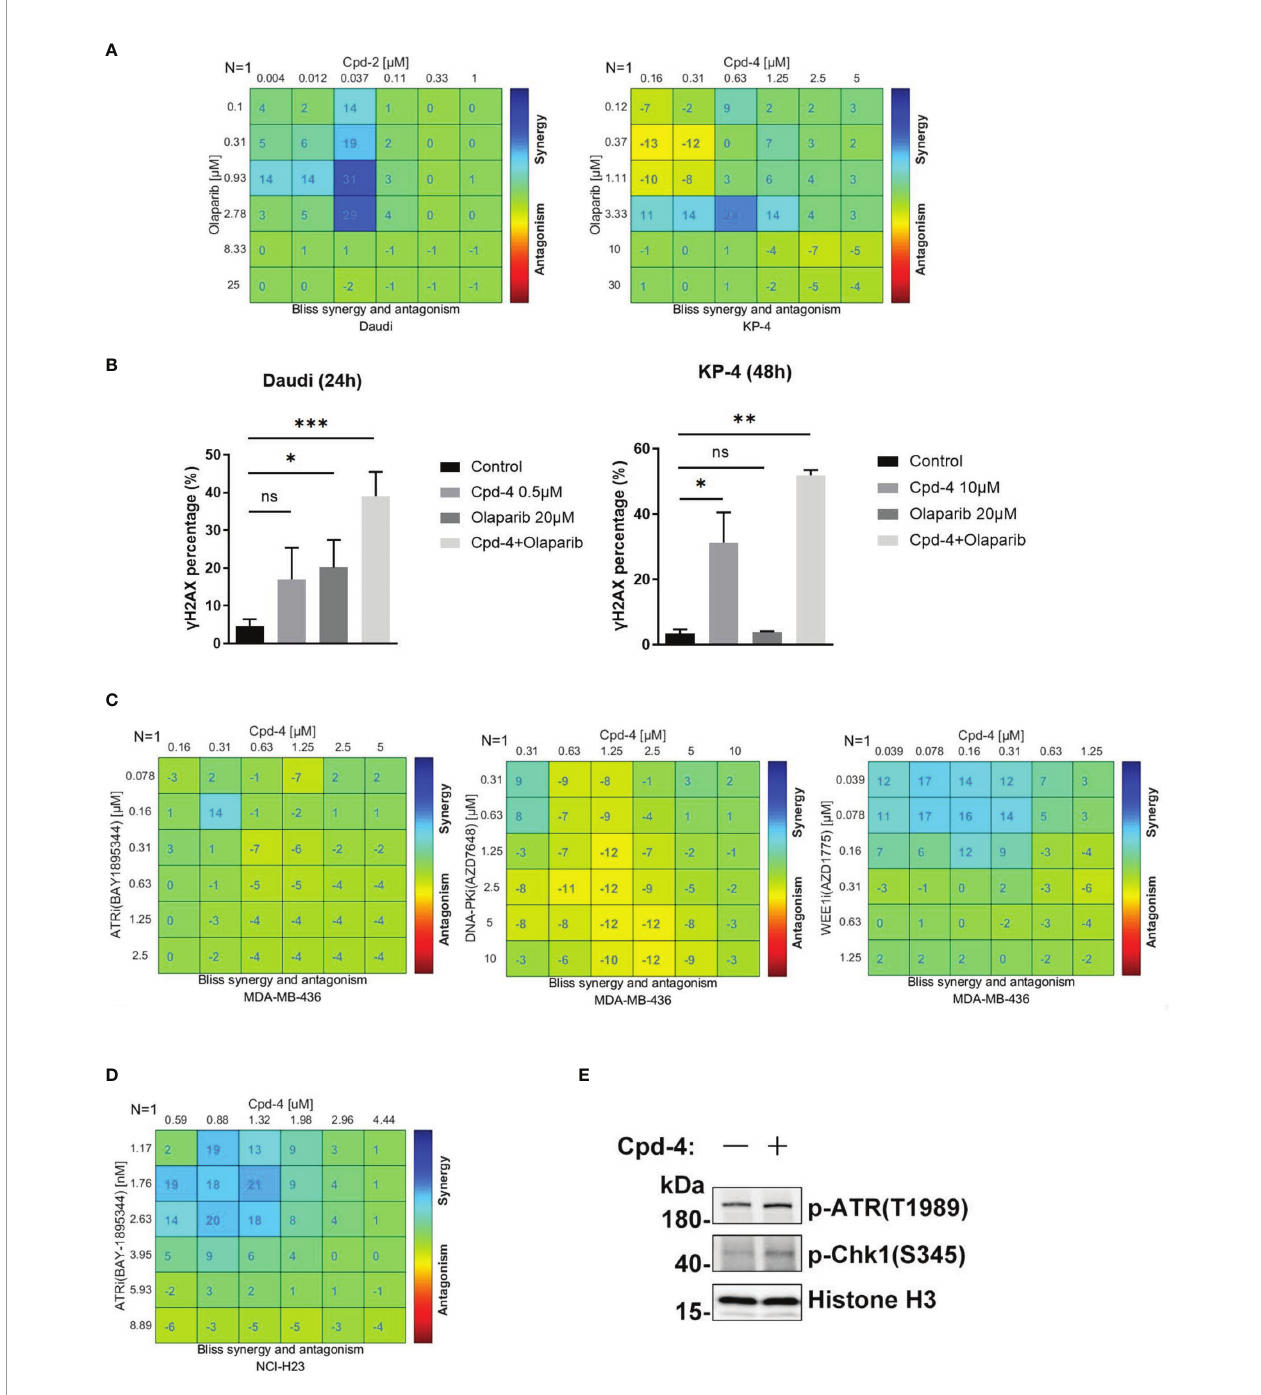
FIGURE 5 | RAD51 inhibition synergizes with DDR-targeting agents on cell proliferation. (A) Synergy effect of compounds and olaparib in Daudi and KP-4 cells. Cells were dosed with Cpd-4 and Olaparib in a 6×6 concentration grid in 96-well plate for 5-7 days. Cell viability was determined with CellTiter-Glo reagent. The experimental data were analyzed with bliss synergy model using the Combene fi t software. Data are representative of at least two independent experiments. (B) g H2AX expression analyzed after cells exposed to drugs combination. Cells were treated with DMSO, Cpd-4, Olaparib or drug combination for 24 h (Daudi) or 48 h (KP-4), then cells were stained with g H2AX antibody and analyzed by fl ow cytometry. (C) Synergy analysis of compound and ATRi (BAY1895344), DNA-PKi (AZD7648) or WEE1i (AZD1775) combination in MDA-MB-436 cells. (D) Synergy analysis of compound and ATRi (BAY1895344) combination in NCI-H23 cell lines. (E) ATR-Chk1 signaling was up- regulated under the compound treatment in NCI-H23 cells. Cells were treated with DMSO or 10 m M Cpd-4 for 6 h before subjected to western blot analysis. *, P<0.05; **, P <0.01; ***, P <0.001, ns, not signi fi